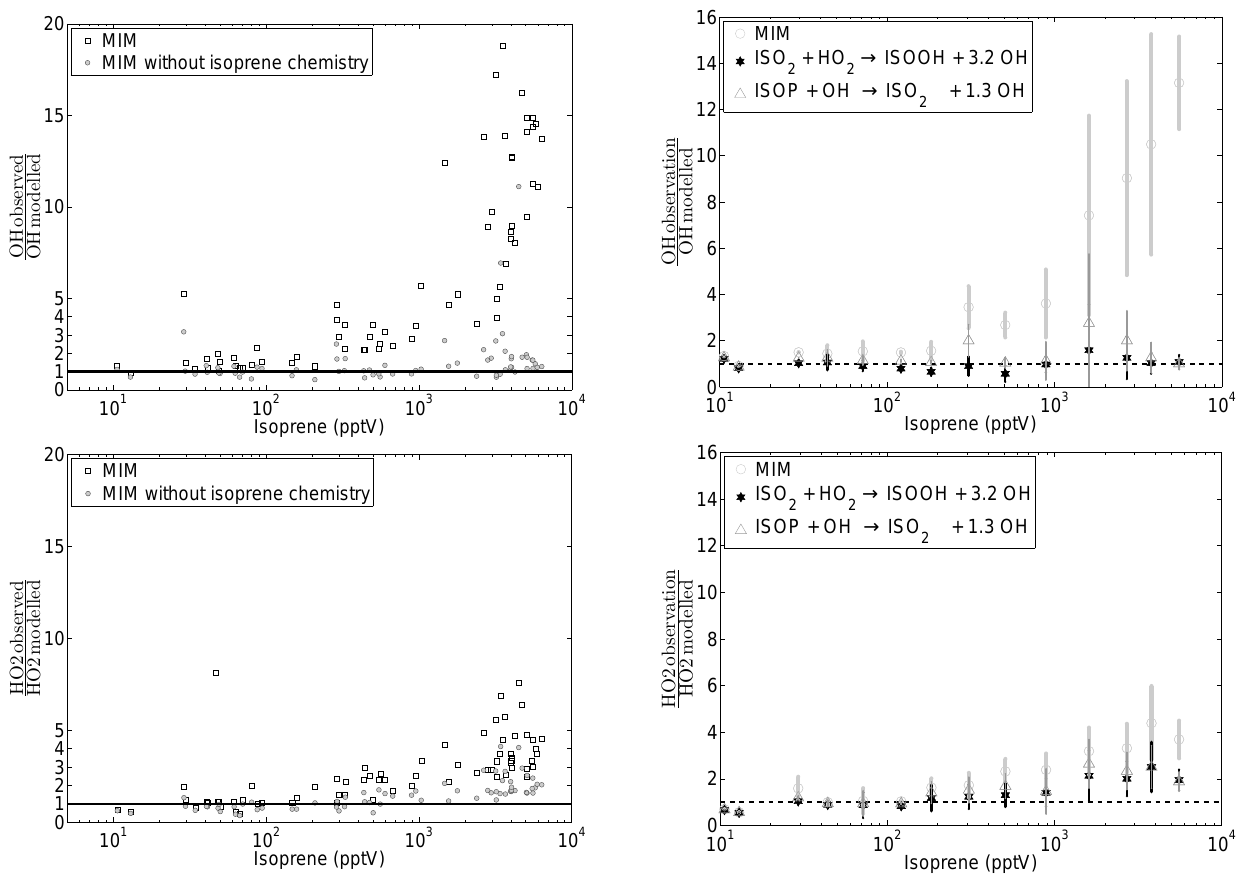
Fig. 17. Comparison between observation and a model run including the additional HO x reaction: ISO 2 + HO 2 → ISOOH + n OH and ISOP + OH → ISO 2 + m OH . Values are binned in isoprene mixing ratios (x) of ∆ln x = 0 . 5 .